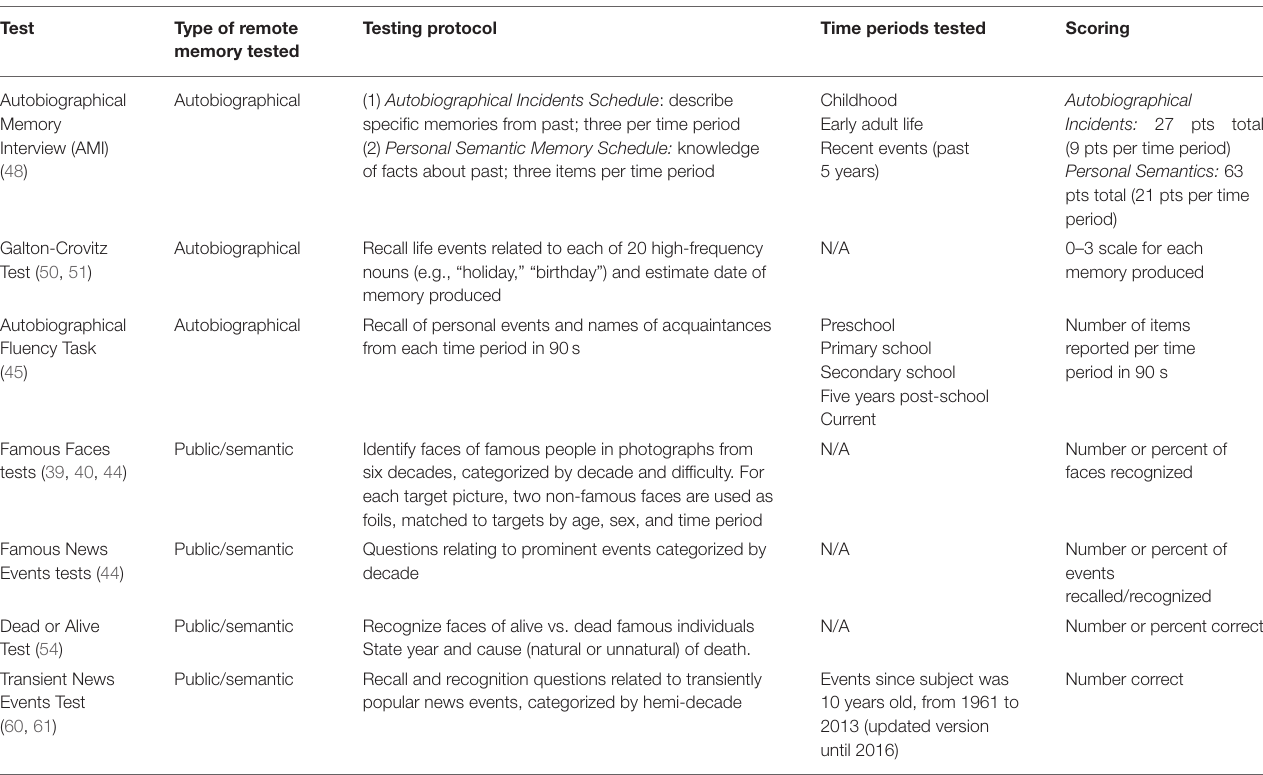
TABLE 2 | Remote memory